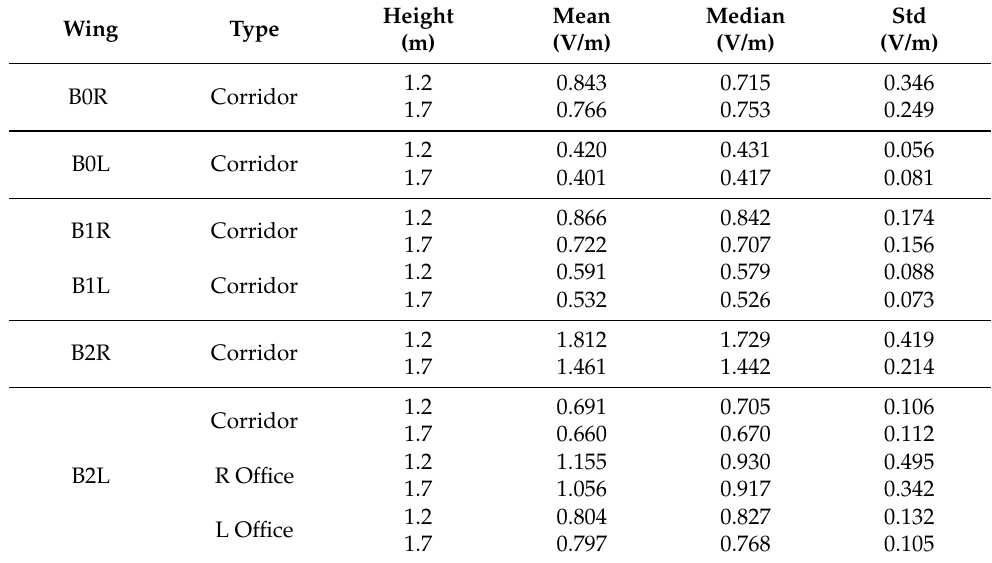
Table 3. Mean, median, and standard deviation of two height measurements for building B.